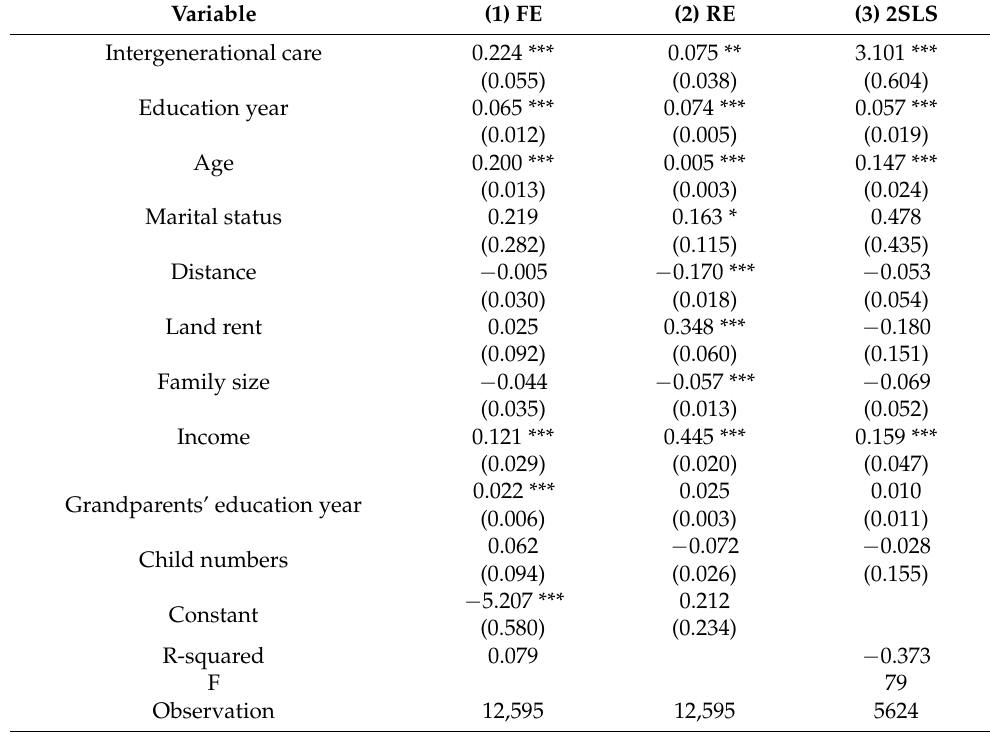
Table 2. The impact of intergenerational care on food diversity for the unbalanced panel data estimated